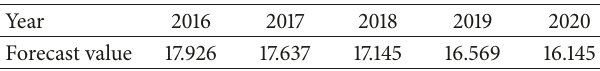
Table 7: Prediction of China’s sulfur dioxide emissions (unit: million